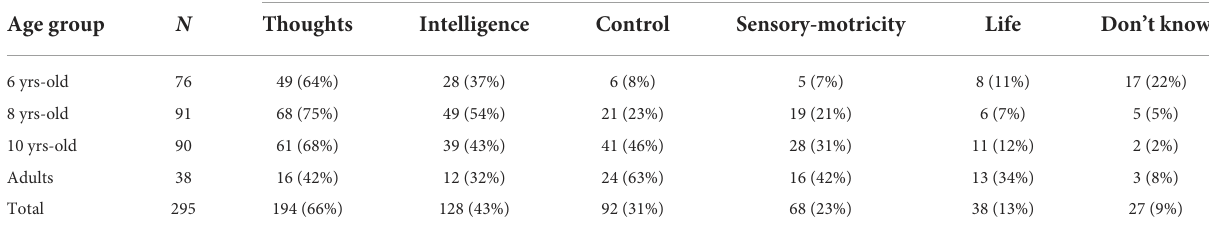
Functions of the